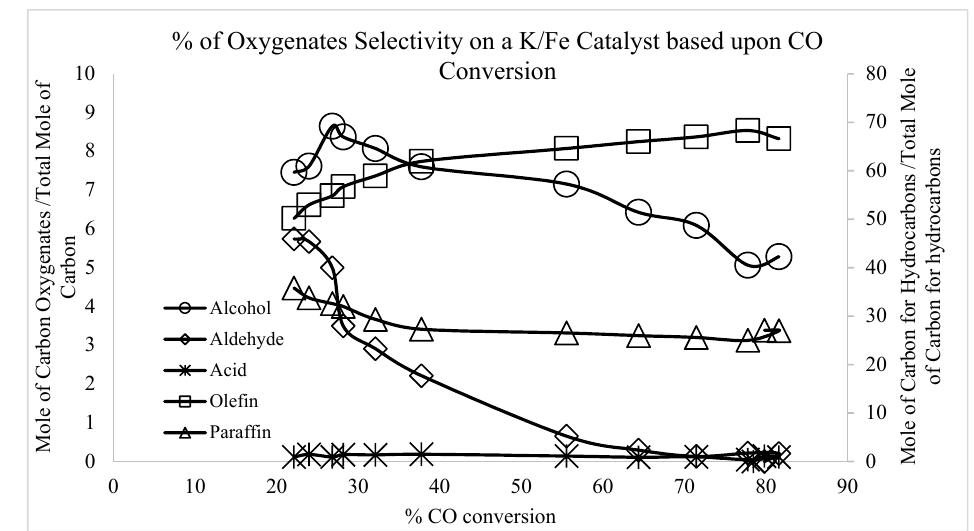
Figure 50. A product distribution of a K/Fe catalyst that shows the dependence of specific oxygenates with respect to the total oxygenates, on CO conversion. Reactor Conditions: 270 °C, 12.1 bar, WHSV = 2, H 2 /CO = 0.7.